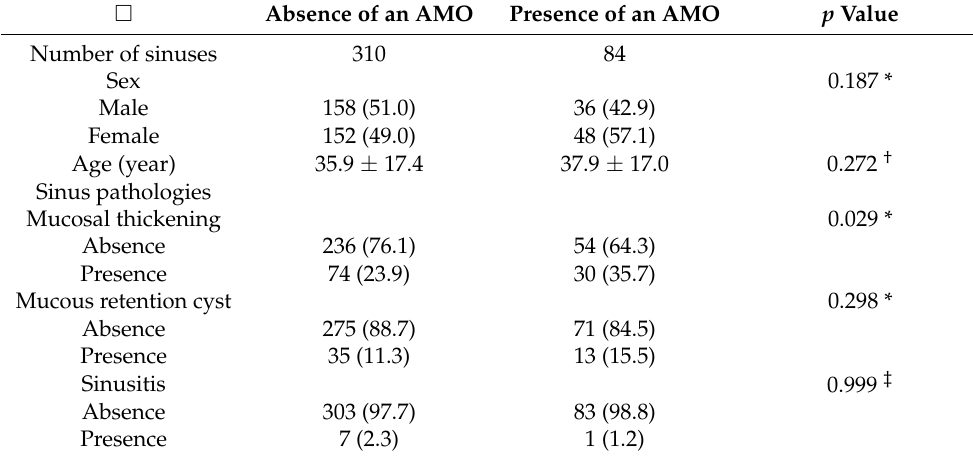
Table 3. Characteristics of the maxillary sinuses according to the absence or presence of an